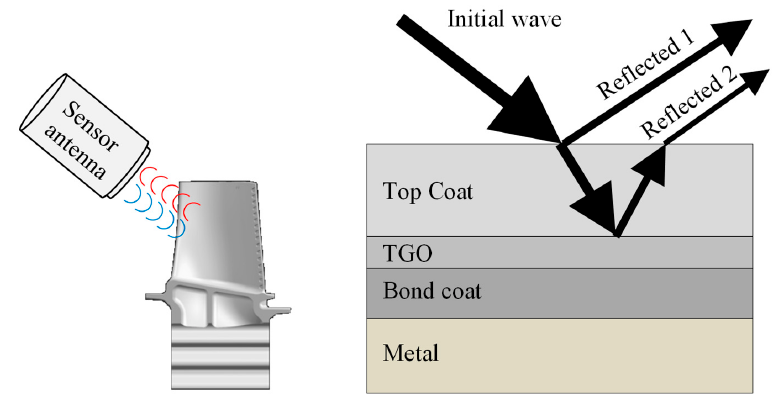
Figure 24. Principle of mm-wave propagation in TBC coating. Figure 25. Principle of mm-wave propagation in TBC coating.